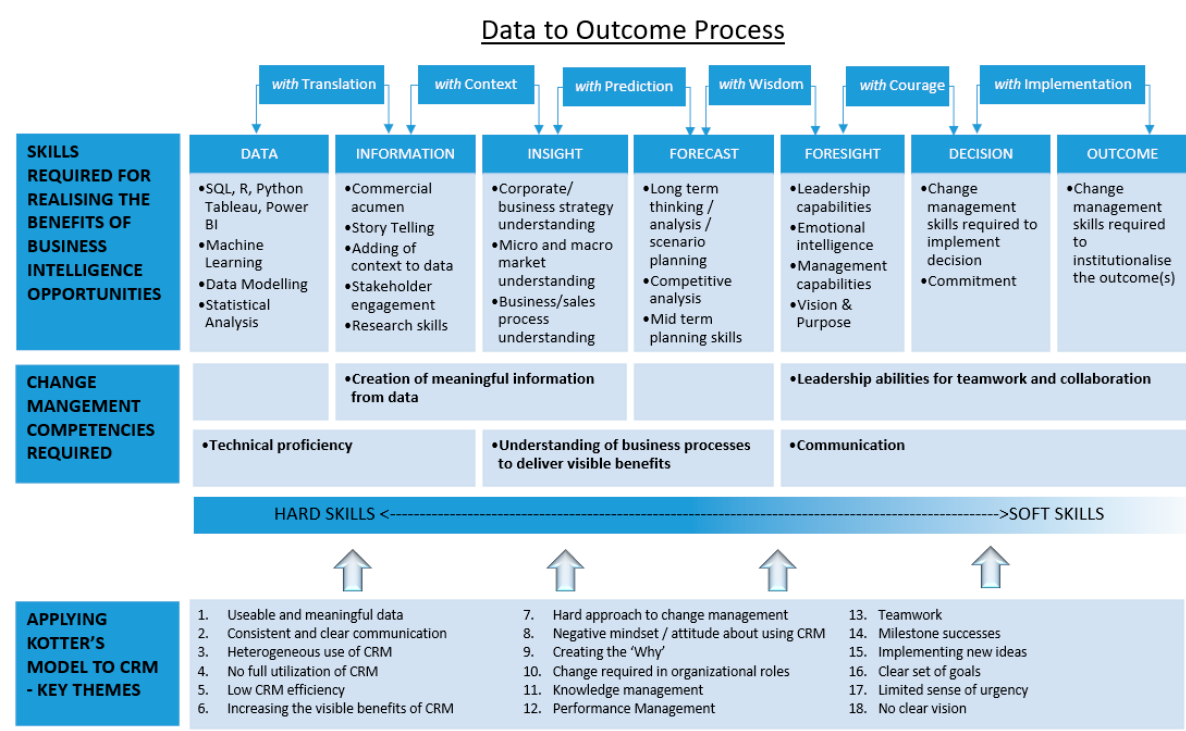
Figure 10. Overlaying the process and skills needed to turn data to business outcomes with the change management skills required, as developed for this study.